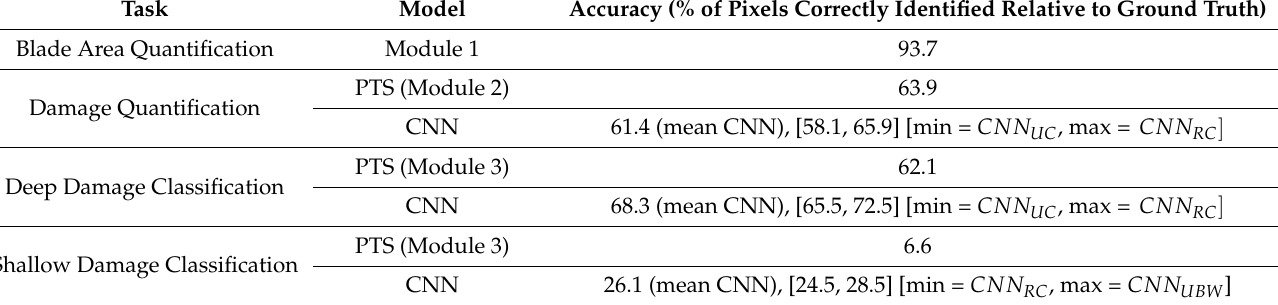
Table 5. Accuracy of the three tasks (blade area quantification, damage quantification, damage classification) for each